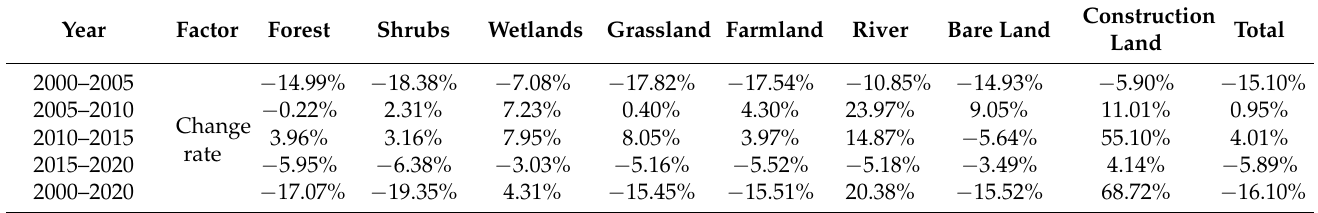
Table 8. ESV change rate by ecosystem class from 2000 to 2020 in Hainan Province.